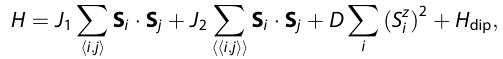
Þ magnetic Bragg peak on an 2